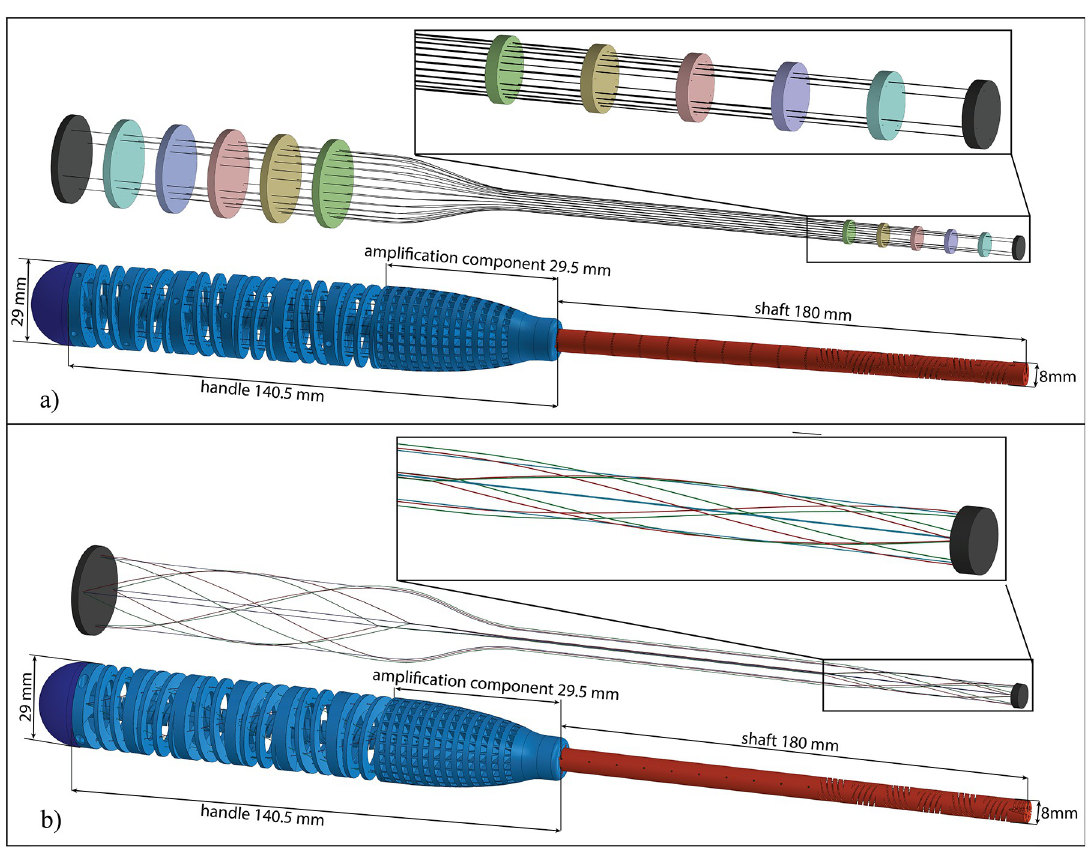
Fig 3. 3D model of the parallel and multi configurations. a) The parallel cable configuration with a close-up on the shaft and the final design of the device. Each color corresponds to a segment mirrored on the control side. b) Multi configuration of the cables and the final design of the device. In this configuration, all cables are connected at the ends. The close-up shows the cable configuration in the steerable